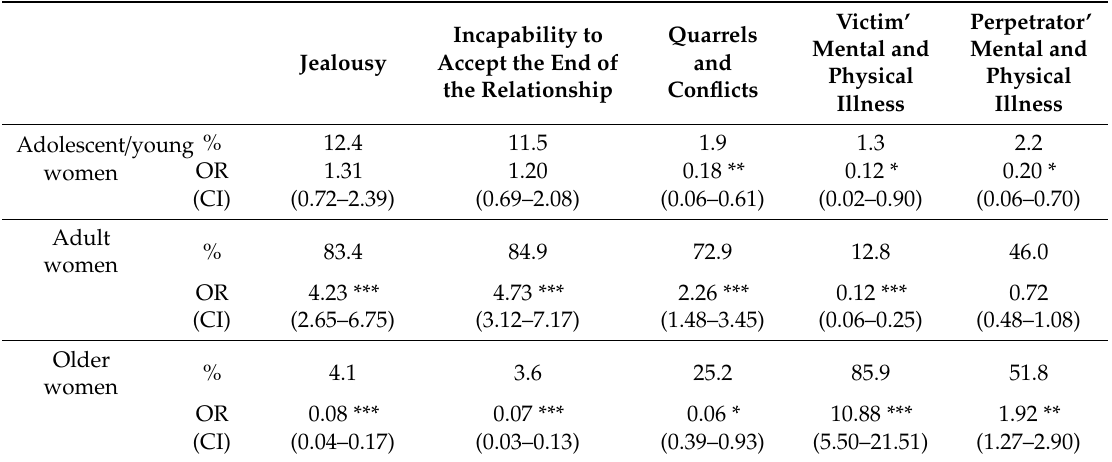
Table 4. Comparison of motives of femicide for each age range against the rest. Incapability to Jealousy Accept the End of the Relationship